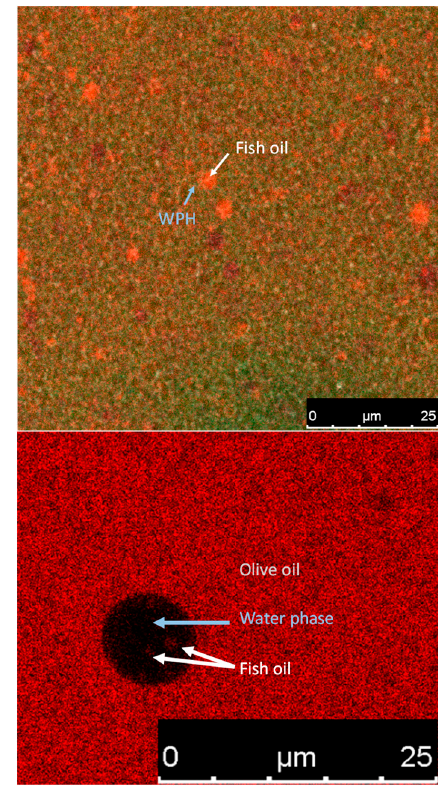
Figure 1. Confocal microscopy images of ( a ) simple O 1 /W emulsion and ( b ) double O 1 /W/O 2 emul- sion.